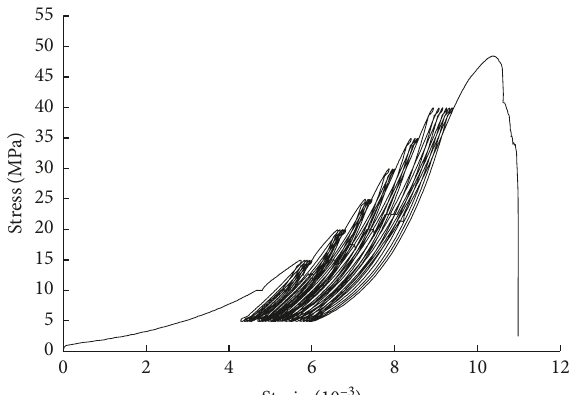
Figure 6: Typical rock sample stress-strain curve in different water- rock cycles.